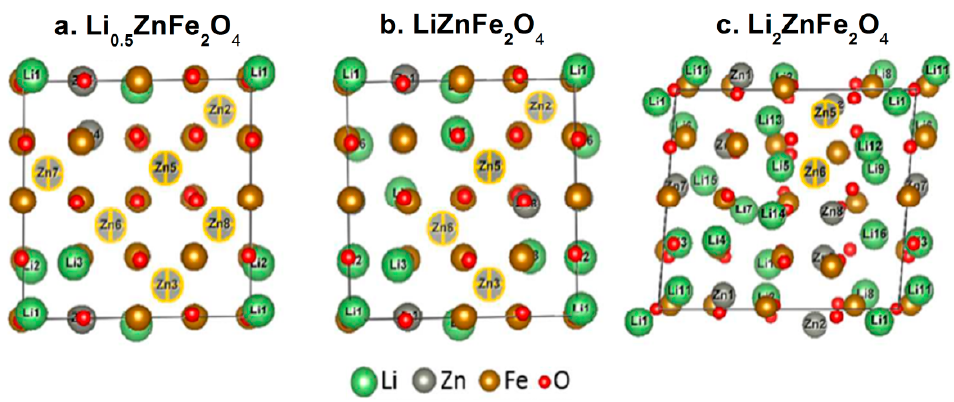
Figure 13. Structures of ( a ) Li 0 . 5 ZnFe 2 O 4 , ( b ) LiZnFe 2 O 4 , and ( c ) Li 2 ZnFe 2 O 4 . (grey with a yellow circle: Zn +2 ions in 8a site) (Reproduced with permission from [74]. Copyright American Chemical Society, 2017).